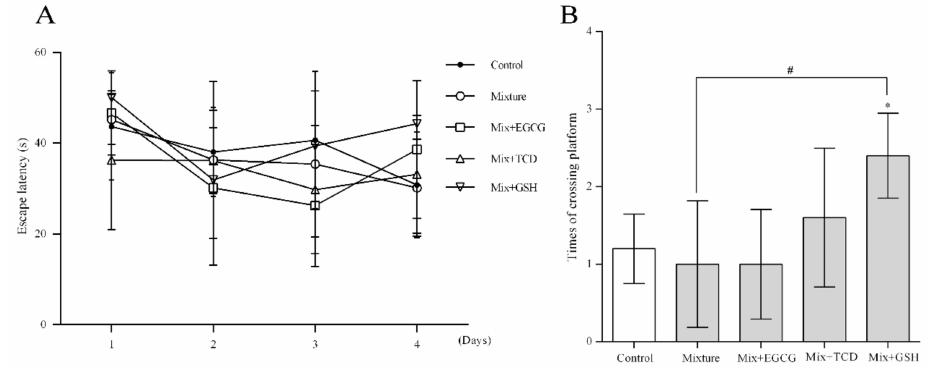
Figure 1. E ff ects of exposure to a heavy metal mixture on spatial learning and memory function, with or without the addition of EGCG, TCD, or GSH. The Morris water test was performed immediately after six months of treatment. Bars represented the times of crossing platform; ( A ) escape latency results of SD rats; ( B ) platform crossing times of SD rats; n = 6 rats / each group; Results were presented as means ± SD; Two-way ANOVA analysis was used in ( A ); One-way ANOVA analysis with LSD-t test was performed in ( B ). * p < 0.05, vs. the control group (Mixture, Mix + EGCG, Mix + TCD, Mix + GSH compared with the control group); # p < 0.05, vs. the Mixture group (Mix + EGCG, Mix + TCD, Mix + GSH compared with the Mixture group); Mix,